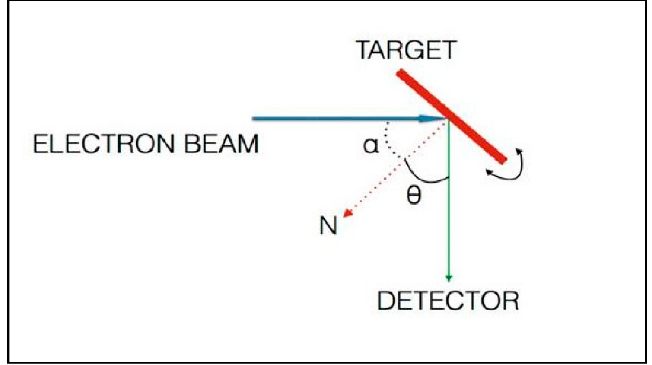
Figure 1. Schematic of the electron beam-target-detector geometry of the employed experimental set up. A = incidence angle, N = normal to the target surface, and θ = photon detection angle equal to (90° −α ).